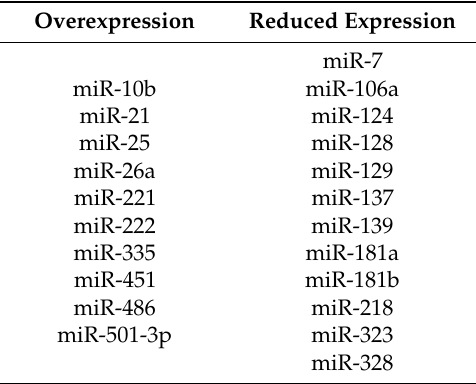
Table 3. Expression of particular miRNA molecules detected in adult HGG